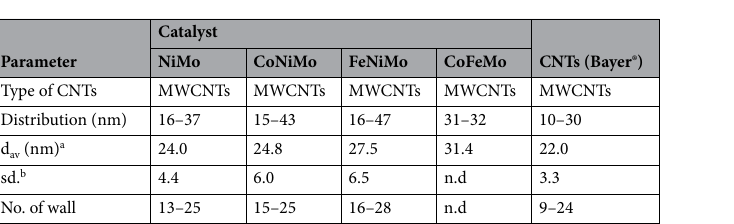
Table 5. Summary of morphology analysis of CNTs synthesized from different catalysts. a Diameter of CNTs calculated by mode. b Standard deviation of CNTs